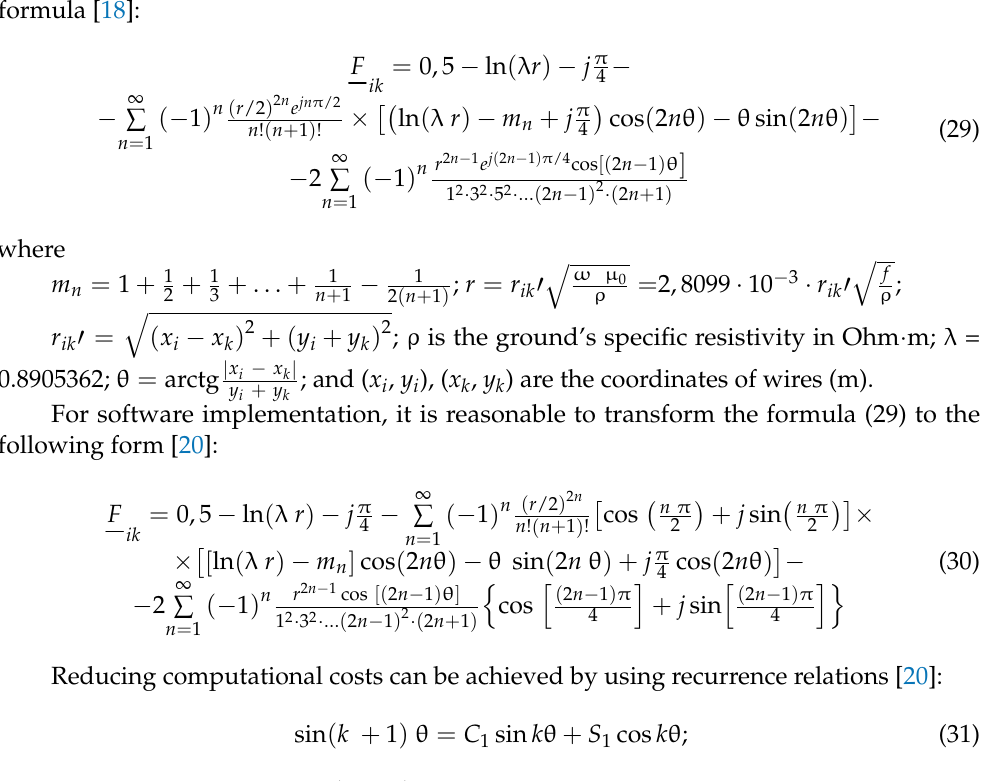
Phase coordinates are the most natural description of three-phase power systems.